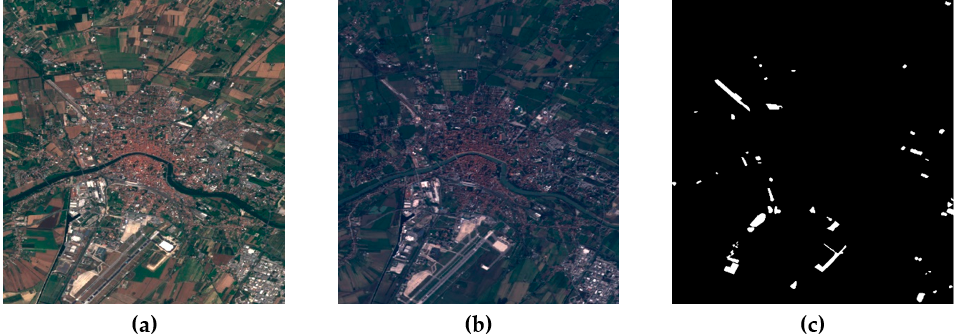
Figure 3. Sample from the OSCD dataset: ( a ) image acquired at time t 1 (RGB); ( b ) image acquired at time t 2 (RGB); ( c ) ground truth (changed areas are shown in white).